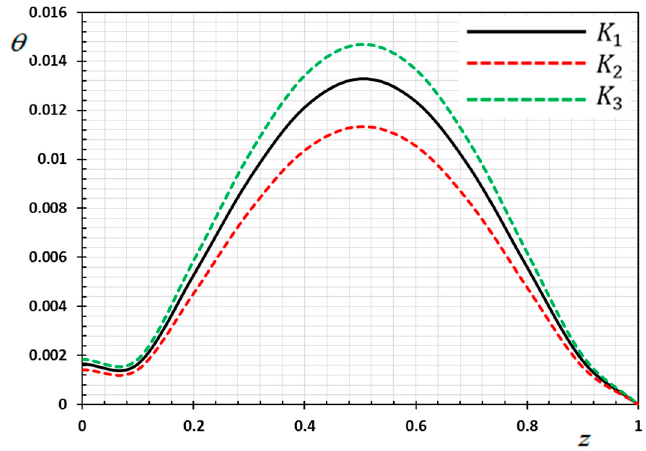
Figure 1. Variation of temperature 𝜃 versus 𝑧 for different forms of kernel function 𝑘(𝑡 − 𝜉) .